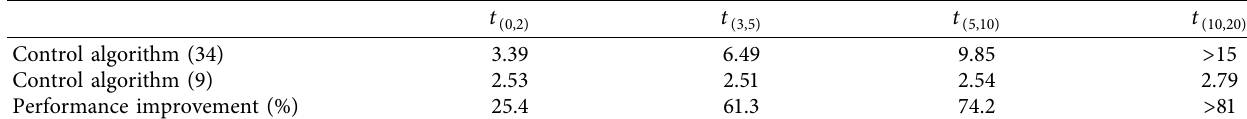
Figure 5: The adjacent distance between every two quadrotors under the control algorithm (9). (a) In the range of (0, 2). (b) In the range of (3, 5). (c) In the range of (5, 10). (d) In the range of (10, 20). Table 2: Comparison results with two control